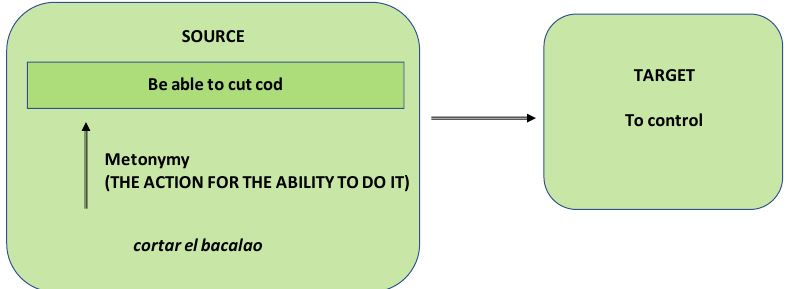
Figure 3. Metonymic expansion of the metaphoric source underlying the interpretation of cortar el bacalao.